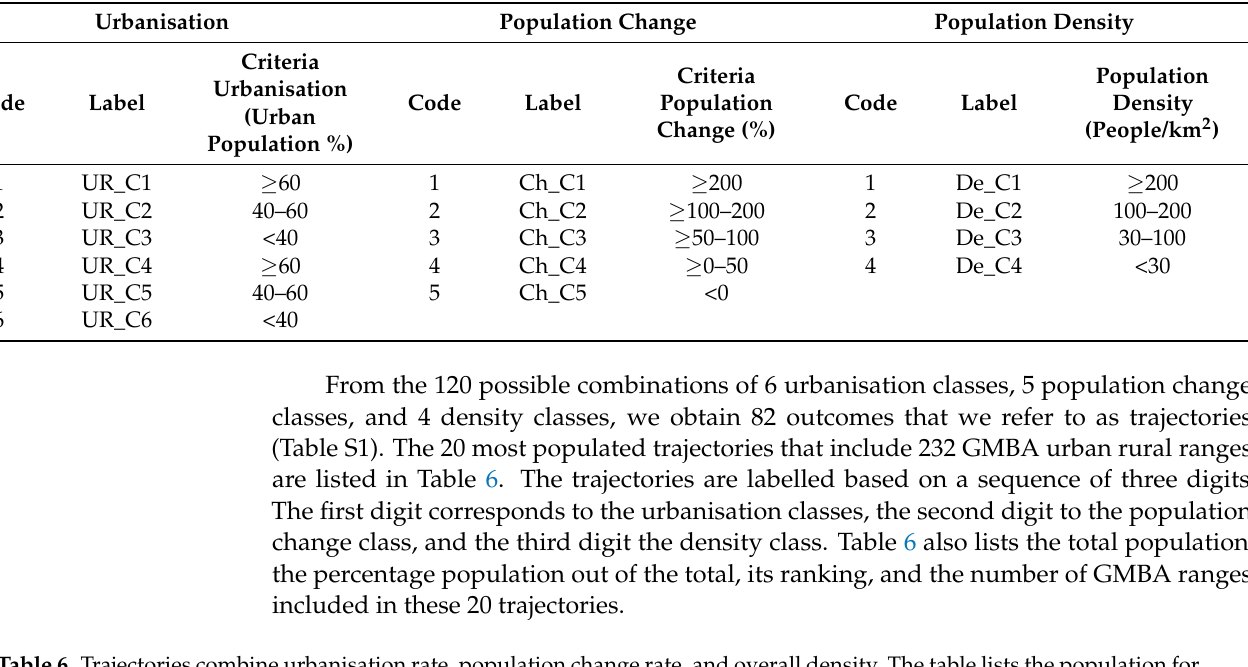
Table 6. Trajectories combine urbanisation rate, population change rate, and overall density. The table lists the population for each trajectory, its relative population referred to the total GMBA population, the number of ranges, and the representative ranges for each